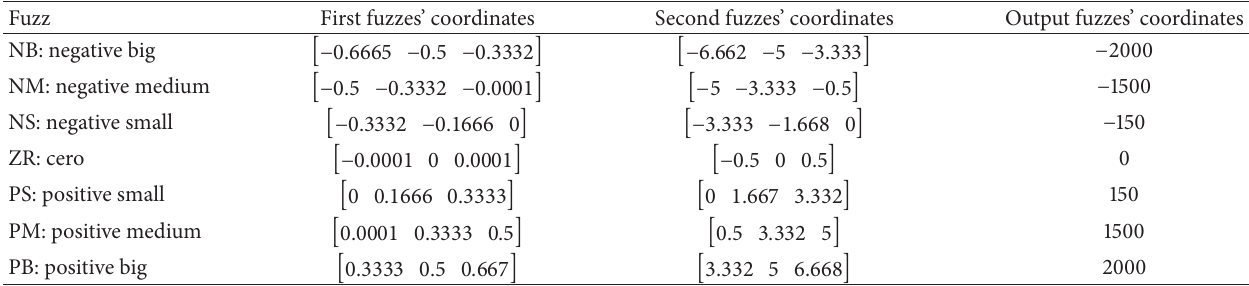
Table 1: Fuzzy membership and output parameters.